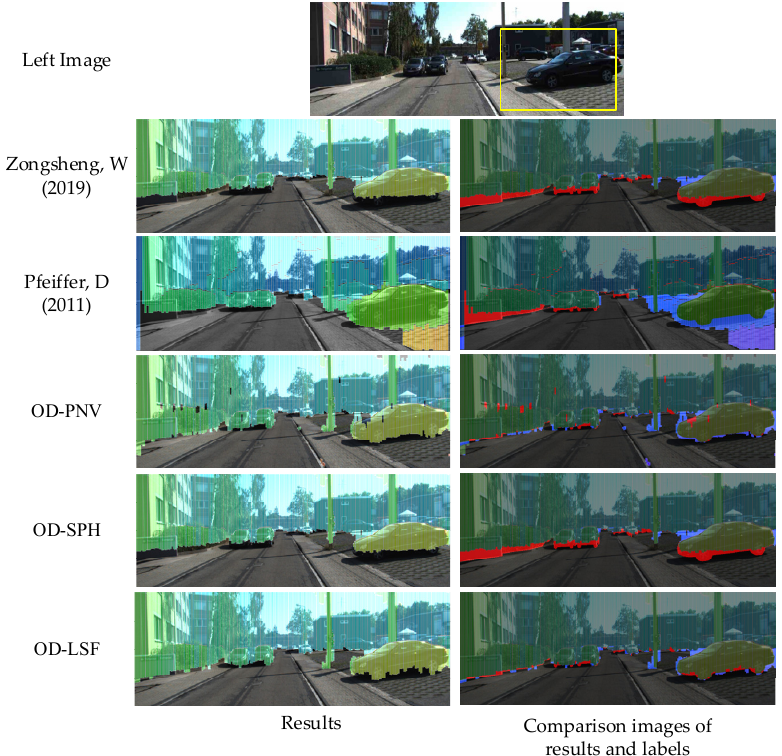
Figure 15. Scene 2 obstacle detection results. Zongsheng, W (2019) represents the Reference [19], Pfeiffer, D (2011) represents the Reference [10].